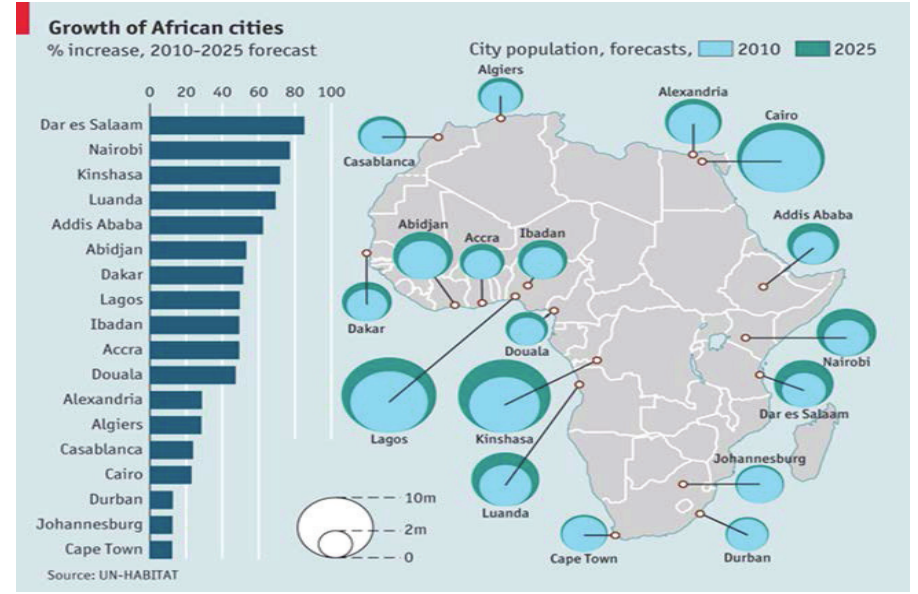
Figure 9: African Cities population increase